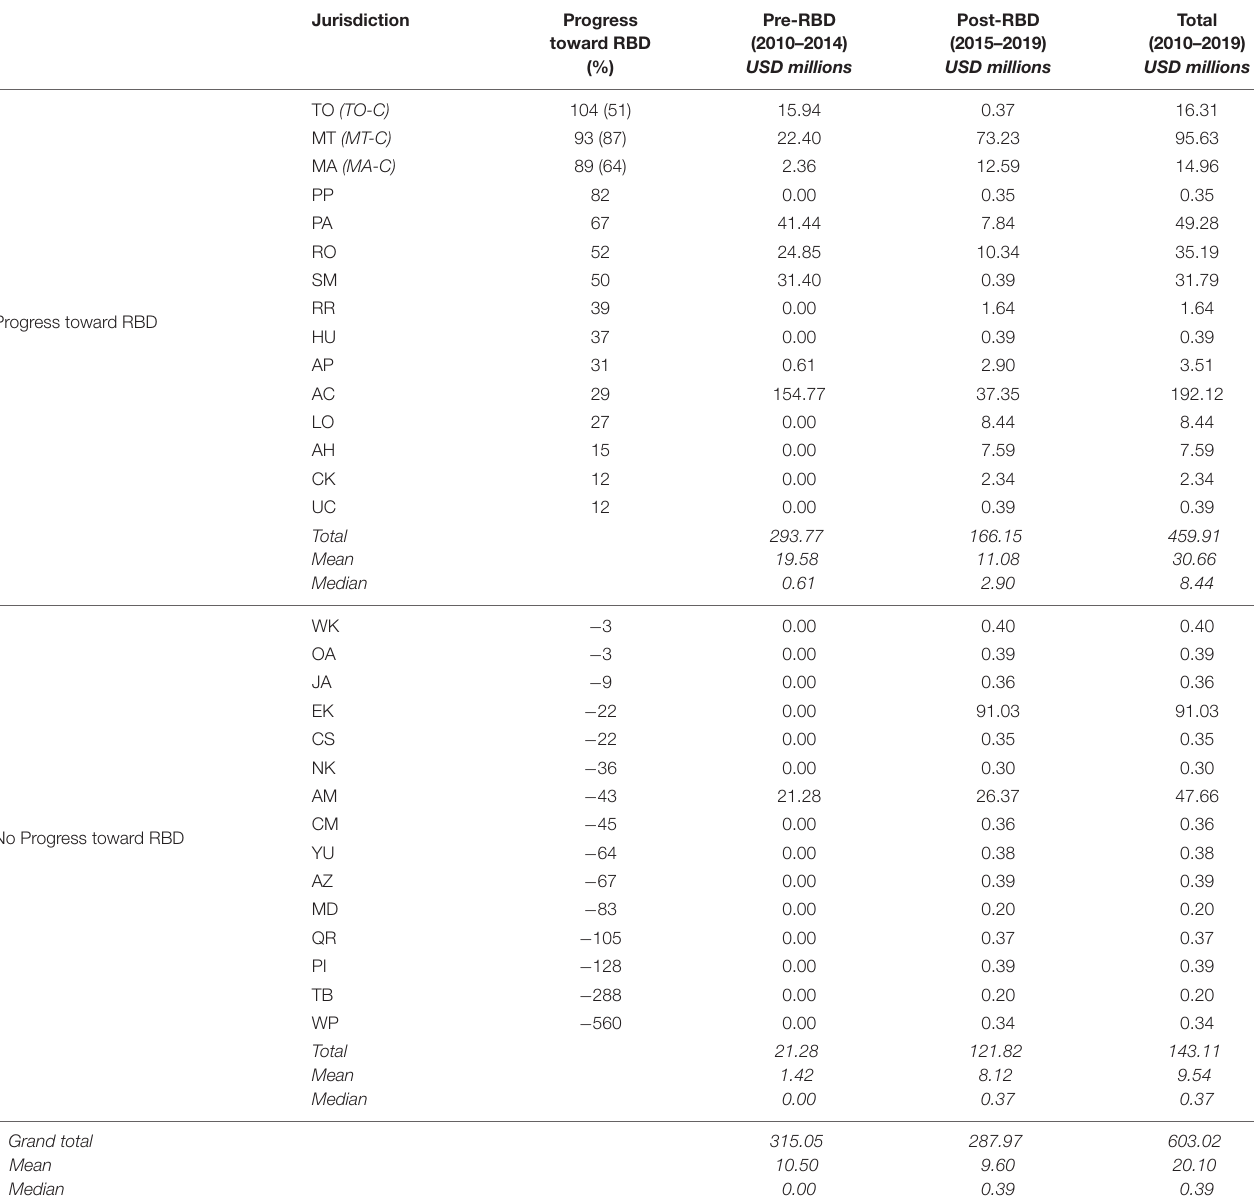
TABLE 9 | Total forest finance pledged to study jurisdictions from 2010 to 2019, ranked according to jurisdictions’ progress toward the RBD deforestation reduction target.